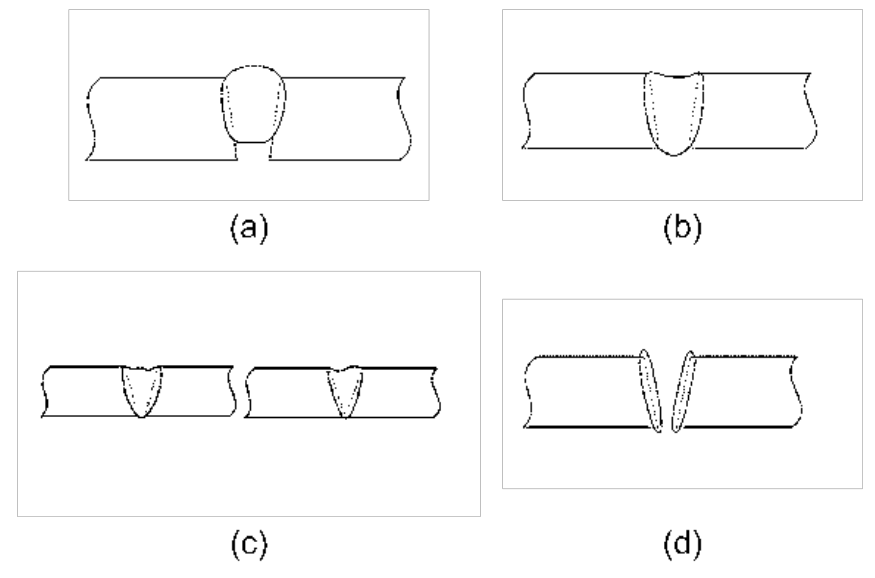
Figure 2. Welding defects: ( a ) incomplete penetration; ( b ) excessive penetration; ( c ) dent; ( d ) burn-through.